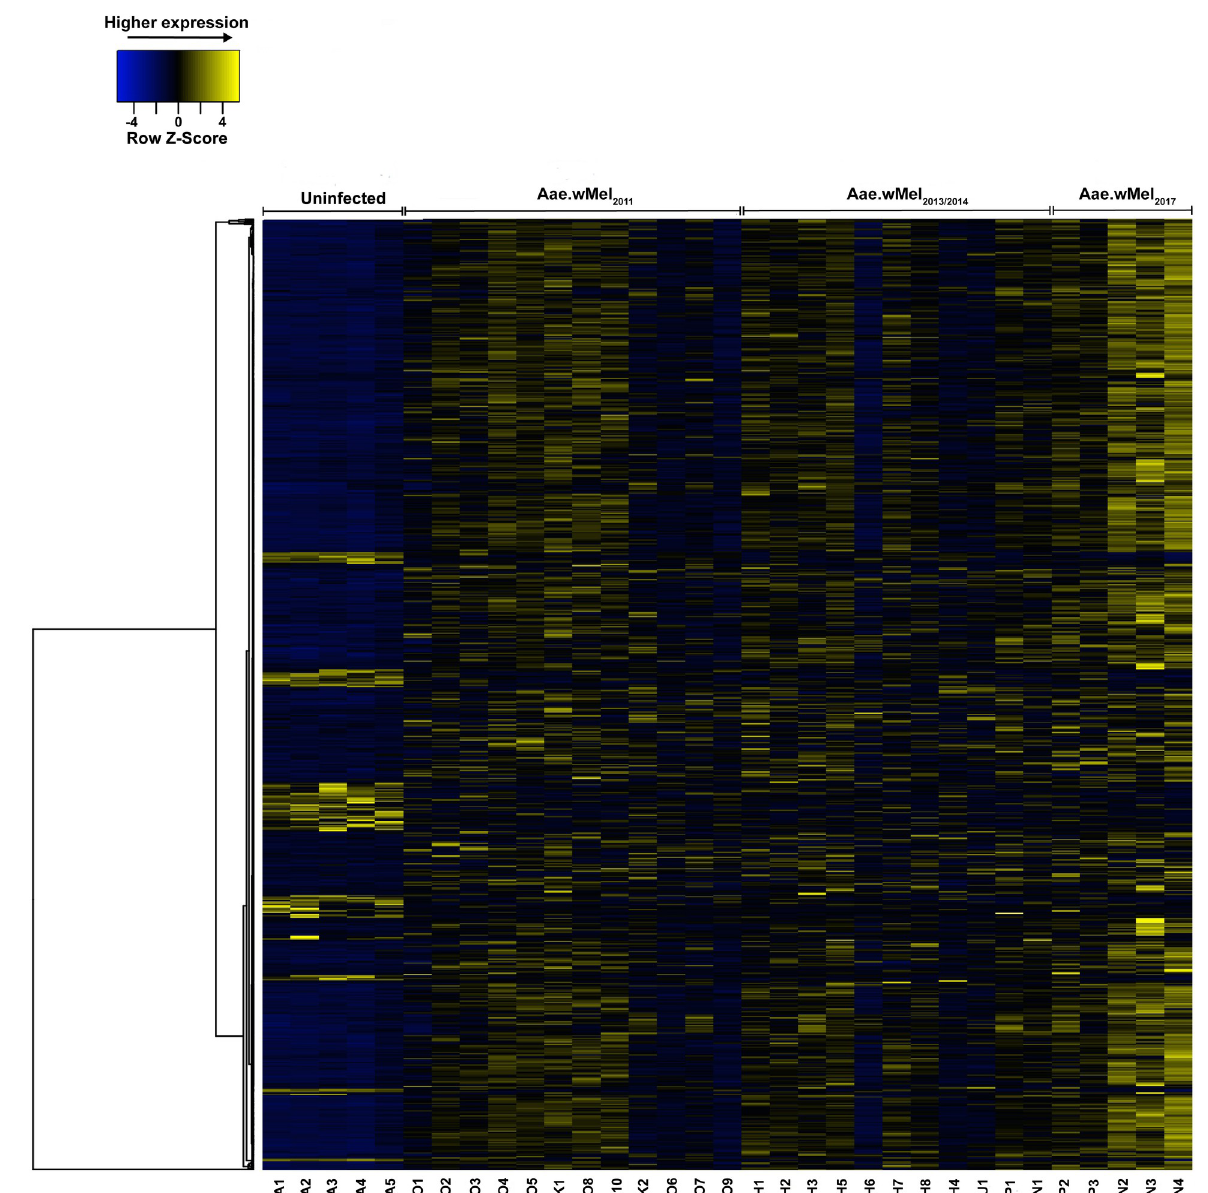
Fig 2. Heatmap of normalised read counts of differentially expressed genes (DEGs) showing clustering of transcriptomic response in w Mel Wolbachia -infected Aedes aegypti from locations with different release years versus uninfected Ae . aegypti . Hierarchical clustering was performed using the complete linkage method and the distances between columns were computed by the Euclidean method (http://www. heatmapper.ca/expression/). Acronyms for the individual mosquito pool identifiers on the X-axis denote suburb names (CA = Caravonica, GO = Gordonvale, YK = Yorkeys Knob, EH = Edge Hill, BU = Bungalow, PP = Parramatta Park, and CN = Cairns North).